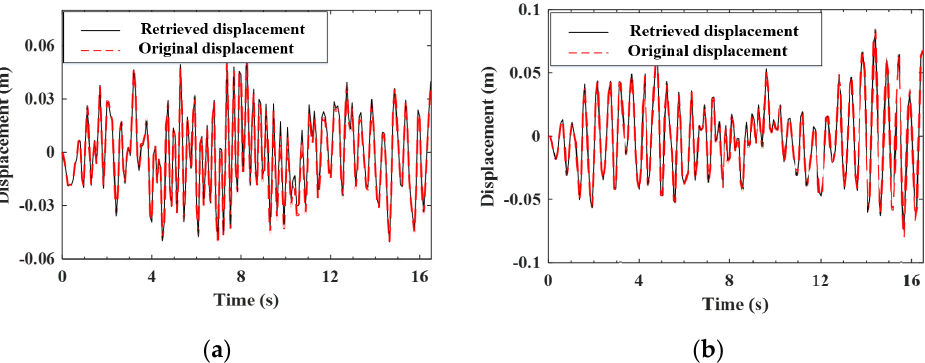
Figure 8. Retrieved and original displacement responses of the test vehicle (Class C roughness). ( a ) front axle; ( b ) rear axle.